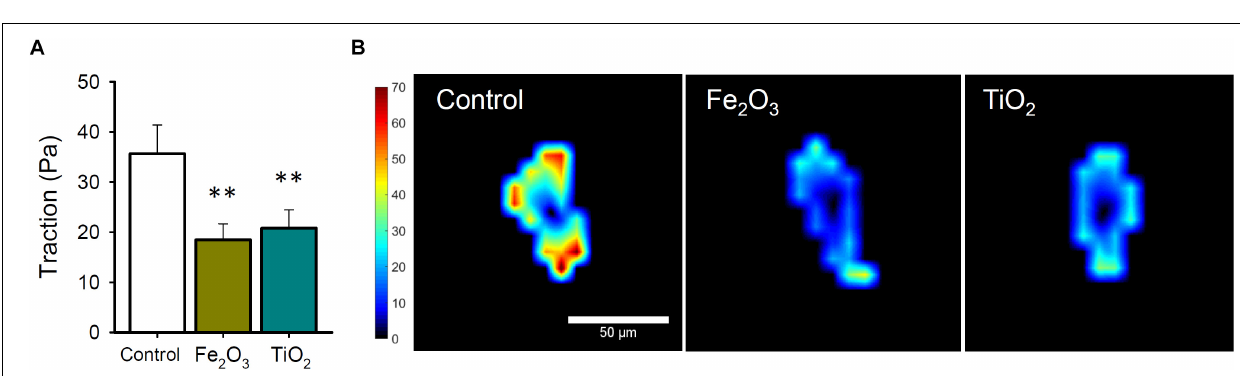
FIGURE 3 | (A) Cell traction forces after 24 h-exposure to Fe 2 O 3 and TiO 2 (10 µ g/mL) NPs or culture medium (CTRL) in A549 cells ( n = 7). (B) Representative maps of cell traction forces for each experimental condition [color scale bar in Pascals (Pa)]. Data are presented as mean ± SE. ∗∗ P <